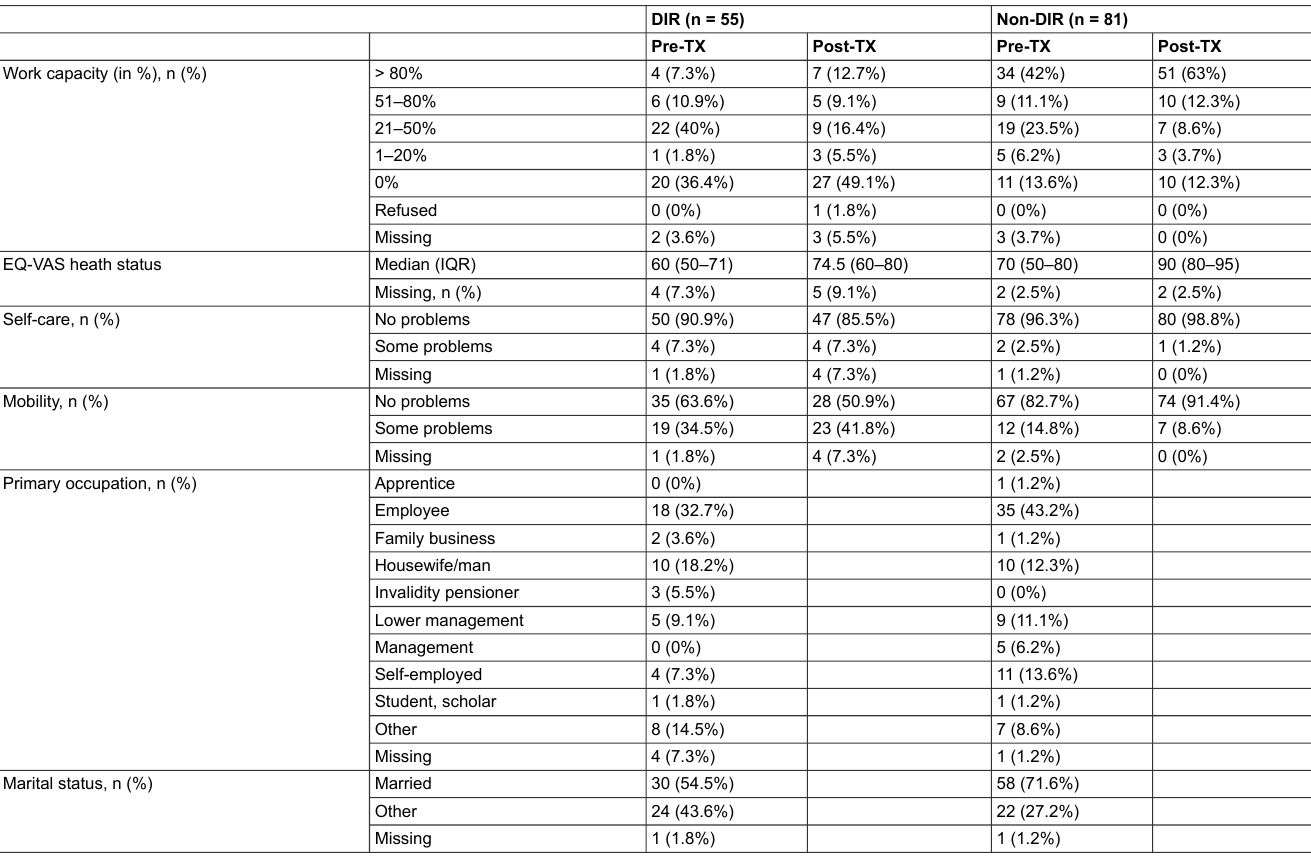
Table 2: Psychosocial characteristics from Swiss Transplant Cohort Study psychosocial questionnaire evaluations stratified by disability insurance recipients (DIR) and non-recipients (non-DIR).